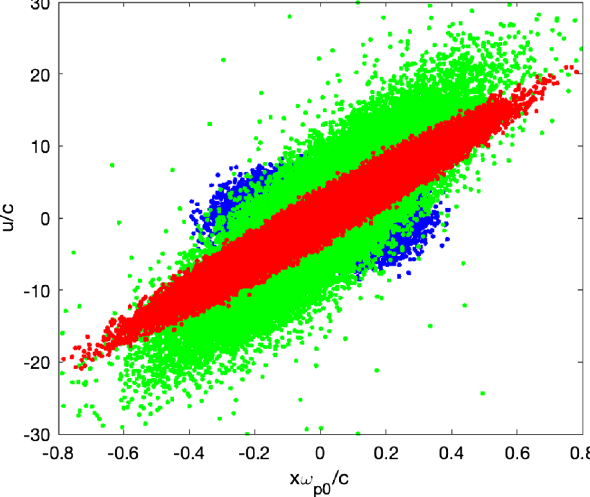
FIG. 2. Phase-space coordinates of 100 000 particles for an initial beam matrix are shown in blue. Red indicates particle coordinates having propagated through a transfer matrix and green shows the coordinates for the corresponding nonlinear matrix with randomly sampled δγ